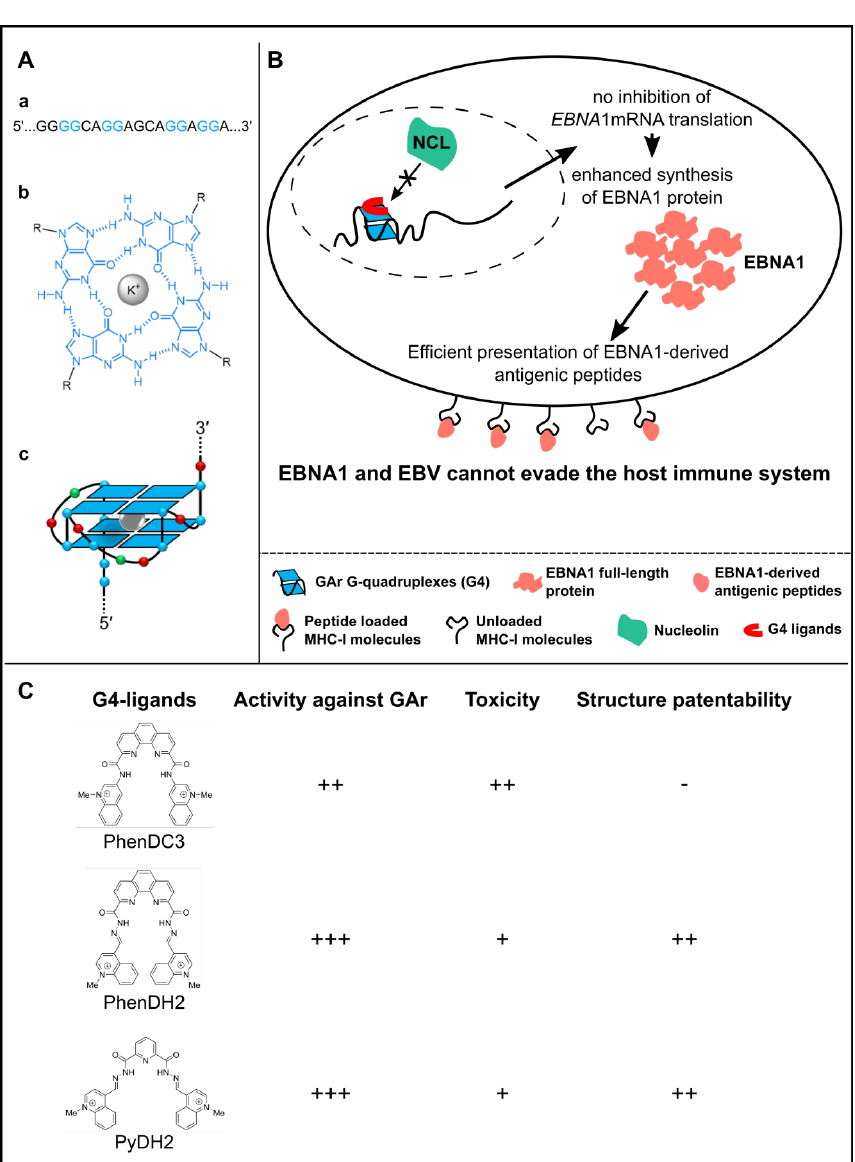
Figure 3. Model of nucleolin (NCL) role in EBNA1 immune evasion and of the mode of action of G4 ligands. ( A ) Structure of a G-quadruplex (G4). G4 are formed by the stacking of G-quartets that consists of a planar arrangement of four guanines connected by Hoogsteen hydrogen bonds and stabilized by a central cation, most often a K + . (a) Sequence of the repeated G4-forming motif within the GAr domain-encoding sequence of EBNA1 mRNA. (b) Structure of a G-quartet, formed by self-association of four guanine residues (blue) with metal cation (K + ); R = ribose residue. (c) Schematic depiction of a putative two-quartet G4 structure formed in the GAr domain-encoding sequence of EBNA1 mRNA; nucleobase colors: G, blue; A, red; C, green. ( B ) Model of the role of NCL in EBNA1 / EBV immune evasion and of the ability of some G4 ligands to interfere with this mechanism. The cellular NCL protein binds to G-quadruplex (G4) that form in the GAr-encoding sequence of the viral EBNA1 mRNA, thereby leading to inhibition of the translation of the latter, thus leading to a limited production of EBNA1-derived antigenic peptides and this way to immune evasion of EBV-infected cells. Some G4 ligands, such as PhenDC3, PhenDH2 or PyDH2, prevent the binding of NCL on G4 of EBNA1 mRNA, thereby interfering with the GAr ability to inhibit translation of its own mRNA, which results in an increase in the production of EBNA1 protein and of EBNA1-derived antigenic peptides. This may unveil EBV-infected cells to the immune system. ( C ) PhenDC3, which is active against GAr [41], does not display an original chemical structure as it is a benchmark G4 ligand. In contrast, PhenDH2 and PyDH2, which are less toxic and more active against GAr than PhenDC3, represent patentable compounds